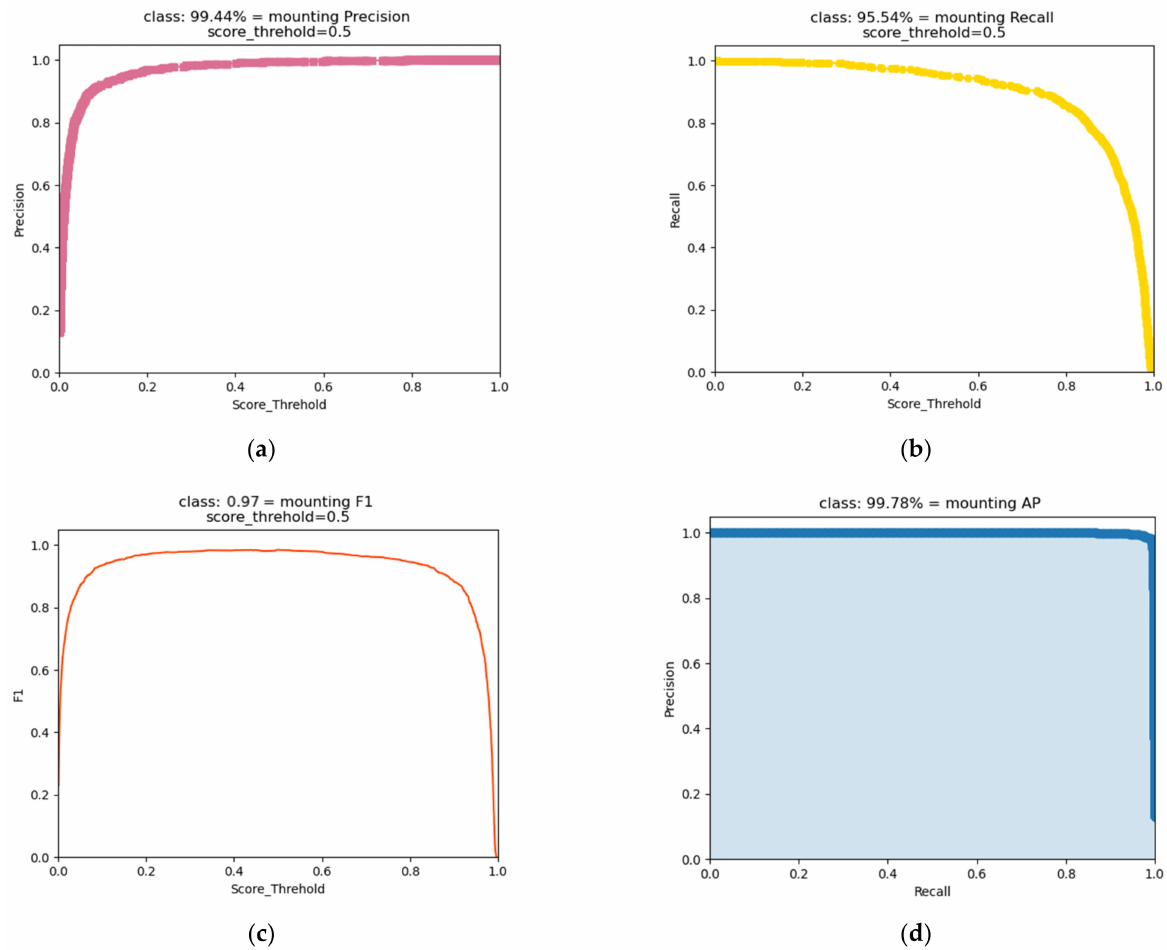
Figure 9. Variation of each index with threshold: ( a ) Curve of P value changing with threshold; ( b ) Curve of R value changing with threshold; ( c ) Curve of F1 value changing with threshold; ( d ) Curve of AP value changing with